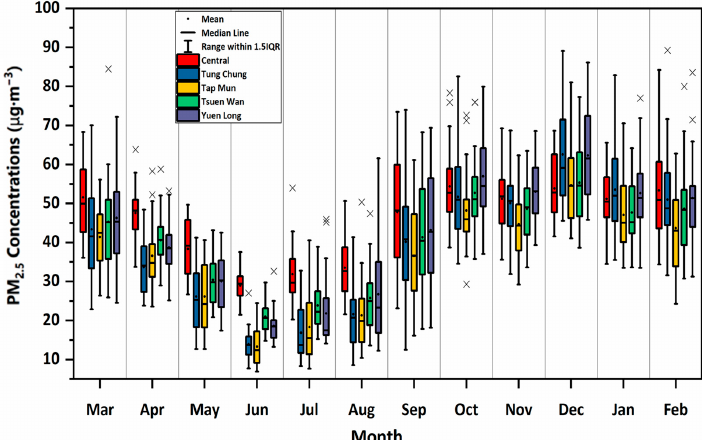
Figure 2. Box plots of the monthly mean of PM 2.5 concentrations from 2005 to 2008 at five air quality monitoring stations (Central, Tsuen Wan, Tung Chung, Yuen Long , and Tap Mun). Where, ‘×’ represents the outliers.